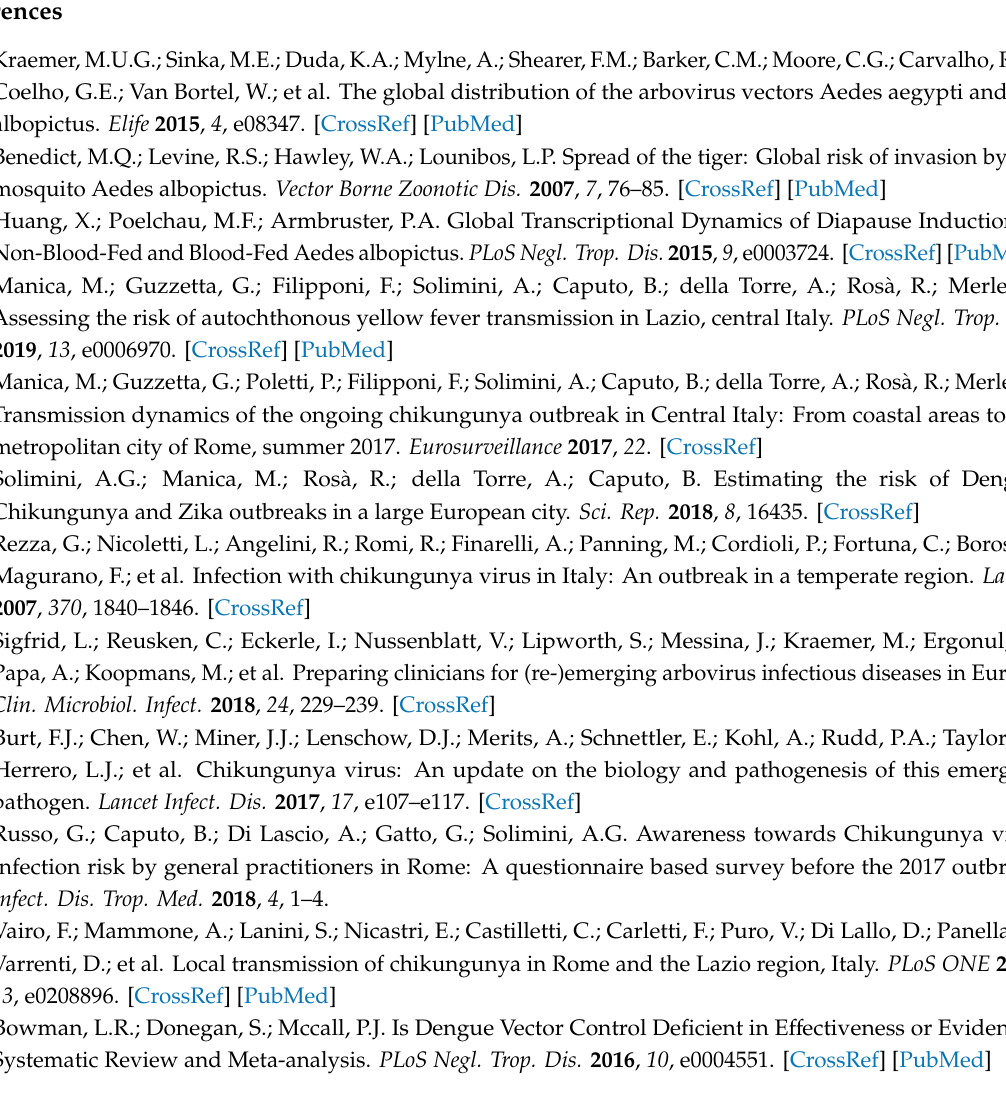
Table S1: Frequency of answers to knowledge, attitude and practice questions in the three groups. For question with multiple answers (i.e. knowledge of Aedes cycle), we reported the frequency of each